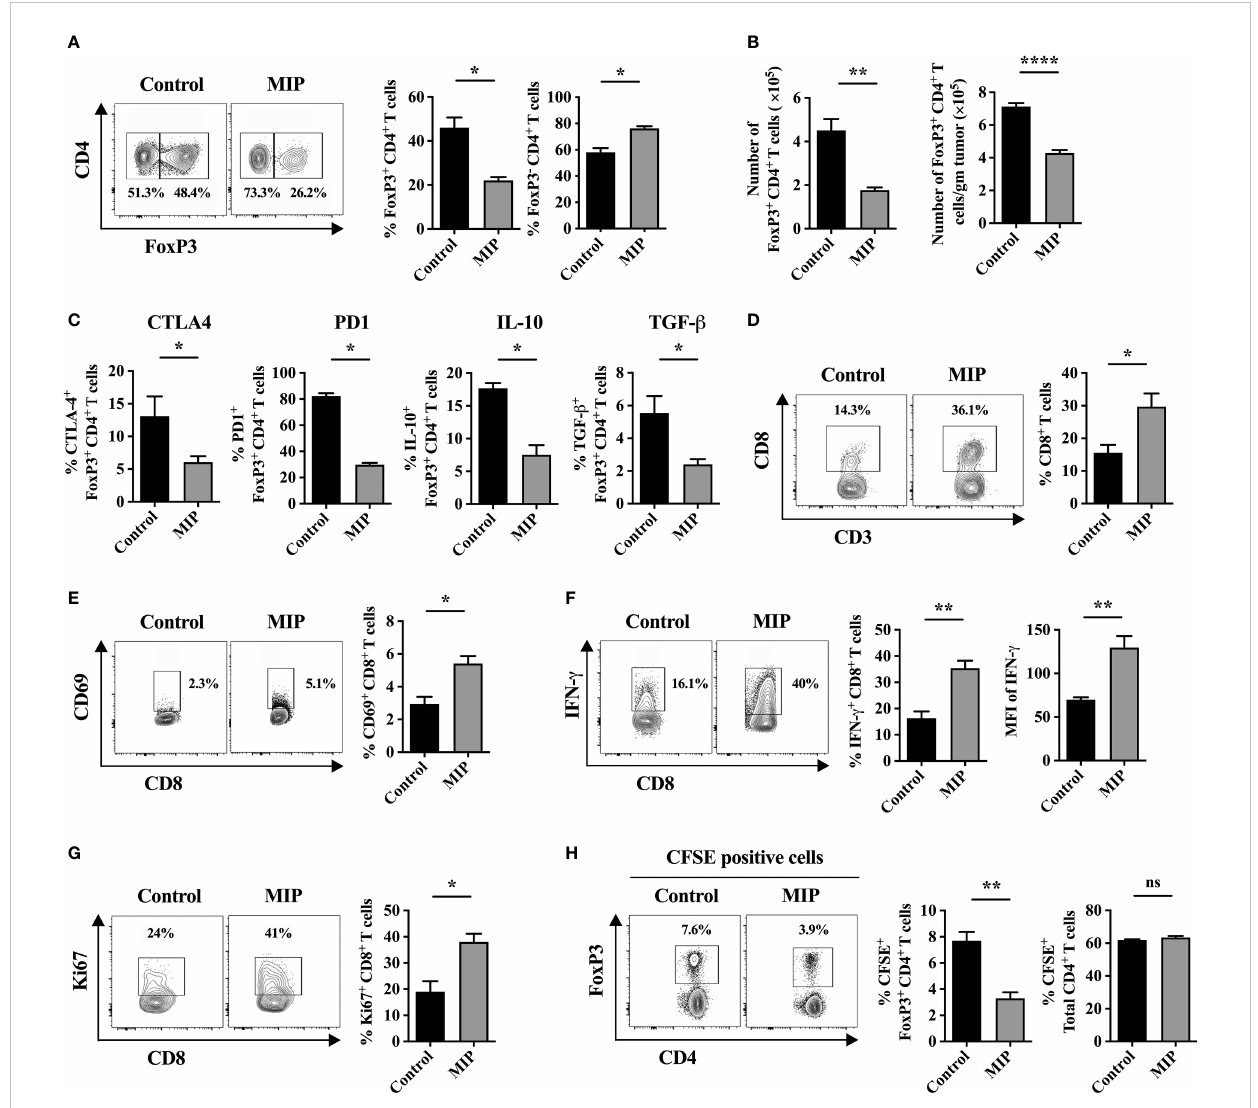
FIGURE 1 Effect of MIP immunotherapy on the frequency and function of tumor in fi ltrating Tregs and CD8 + T cells: (A) Twenty one days post tumor implantation, immune cells were separated from tumor tissue and stained for FoxP3 on live CD3 + CD4 + T cells and analyzed by fl ow cytometry. The control tumor bearing mice were treated with PBS (vehicle control). The contour plots represent one tumor bearing mouse per group showing the percentage of FoxP3 + cells within tumor-in fi ltrating CD4 + T cells. (B) (Left) Speci fi c number of tumor-in fi ltrating CD4 + FoxP3 + Tregs; (Right) Number of tumor-in fi ltrating CD4 + FoxP3 + Tregs per gram of tumor (n=5 mice/group). (C) Percent frequency of Tregs expressing CTLA4, IL10, TGF- b and PD1 in Control and MIP treated TME (n=4 mice/group). (D) Flow-cytometric analysis of percentage of intratumoral CD8 + T cells in control/MIP treated mice. The contour plots represent one tumor bearing mouse per group. (E) Percent frequency of activated CD8 + T cells in the TME. (F) Flow cytometric analysis of IFN- g producing CD8 + T cells in the TME of control and MIP treated mice. (G) Percent frequency of potentially proliferating CD8 + T cells was determined in the TME by analyzing expression of Ki67 in them. (H) To determine whether MIP immunotherapy suppresses Treg migration into the TME, 24 hours after the third dose of MIP, CFSE-labeled splenocytes of healthy donor mice were adoptively transferred by retro- orbital route into the tumor bearing mice. Tumors were resected 18 hours after adoptive transfer, followed by fl ow cytometric analysis of intratumoral CFSE + Treg cells and CFSE + total CD4 + T cells. Representative contour plots showing the frequency of CFSE + Tregs in one mouse per group. All fi ndings are shown as bar graphs that represent the mean ± SEM of fi ve mice per group in one experiment. Statistical signi fi cance was determined by unpaired non-parametric student ’ s t-test (*:p<0.05; **:p<0.01; ****:p<0.0001; ns, non-signi fi cant). Two/three independent repeats were done for all